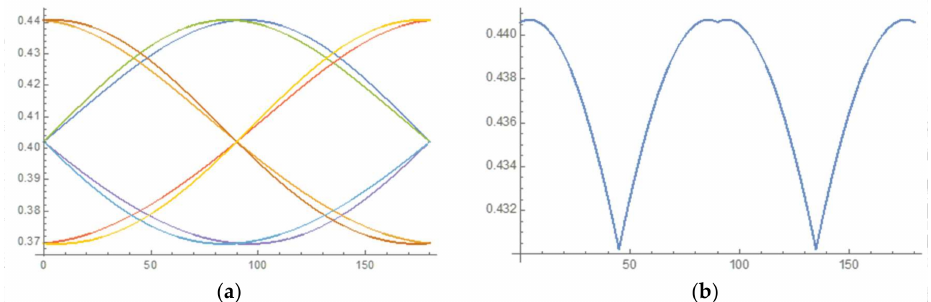
Figure 5. ( a ) Variation of Schmid factor (vertical axis) of the six active slip system as a function of the azimuthal angle of misalignment between the loading direction and the crystal axis [001] in the range 0 ◦ to 180 ◦ (horizontal axis); ( b ) maximum Schmid factor variation as a function of azimuthal angle in the range 0 ◦ to 180 ◦